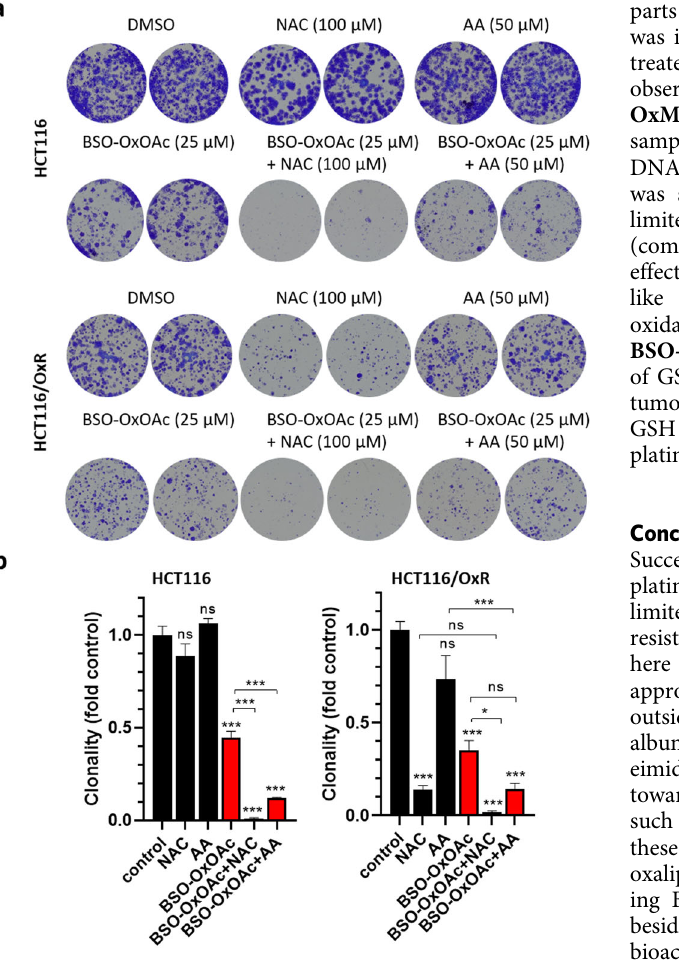
Fig. 6 Impact of BSO-OxOAc as single agent and in combination with the reducing agents NAC (100 µ M) and AA (50 µ M) on the clonogenic potential of HCT116 cells and the subline with acquired oxaliplatin resistance (HCT116/OxR). Sparsely seeded cells (1 × 10 3 /24-well plate well) were exposed for 10 days to the indicated compounds and derived cell clones stained with crystal violet, photographed, and results evaluated by ImageJ software as described in the Methods section. One respective experiment out of three performed in duplicate is shown under ( a ) and the respective evaluation under ( b ), depicted as mean ± SD. Statistical signi fi cance was tested using two-way ANOVA. In all cases: * p < 0.05; ** p < 0.01; *** p <